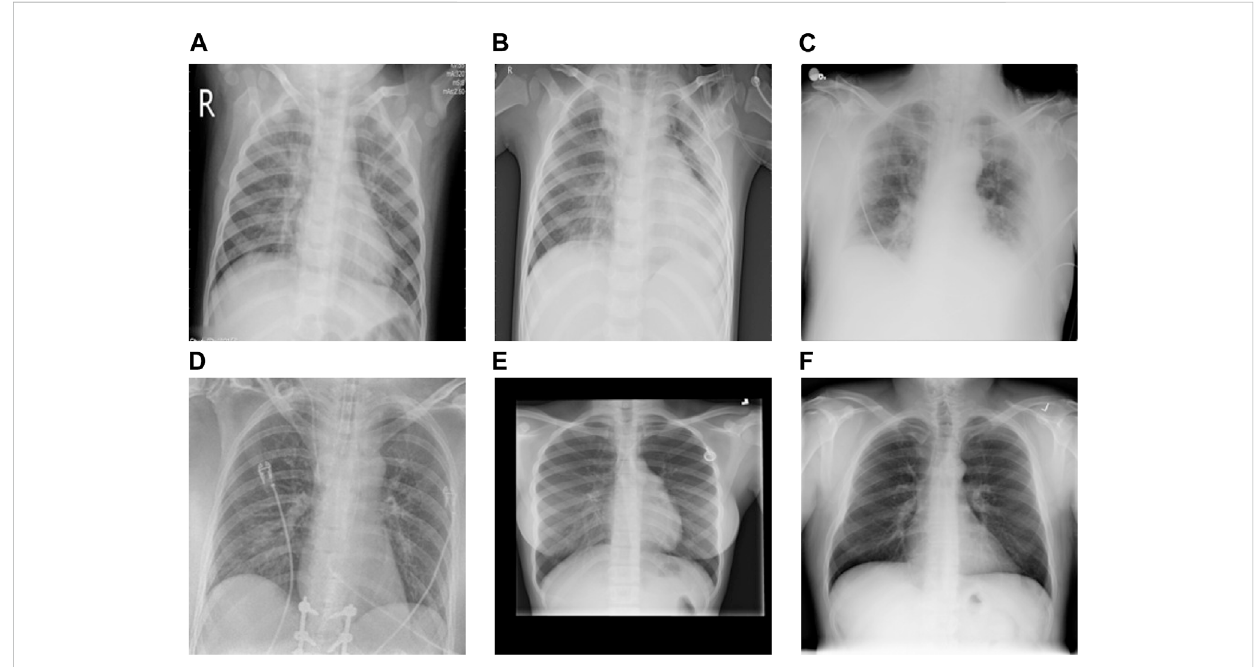
FIGURE 7 Somesamplesfromthedataset: (A,B) imagespositive toviralpneumonia, (C,D) imagespositive toCOVID-19, and (E,F) images